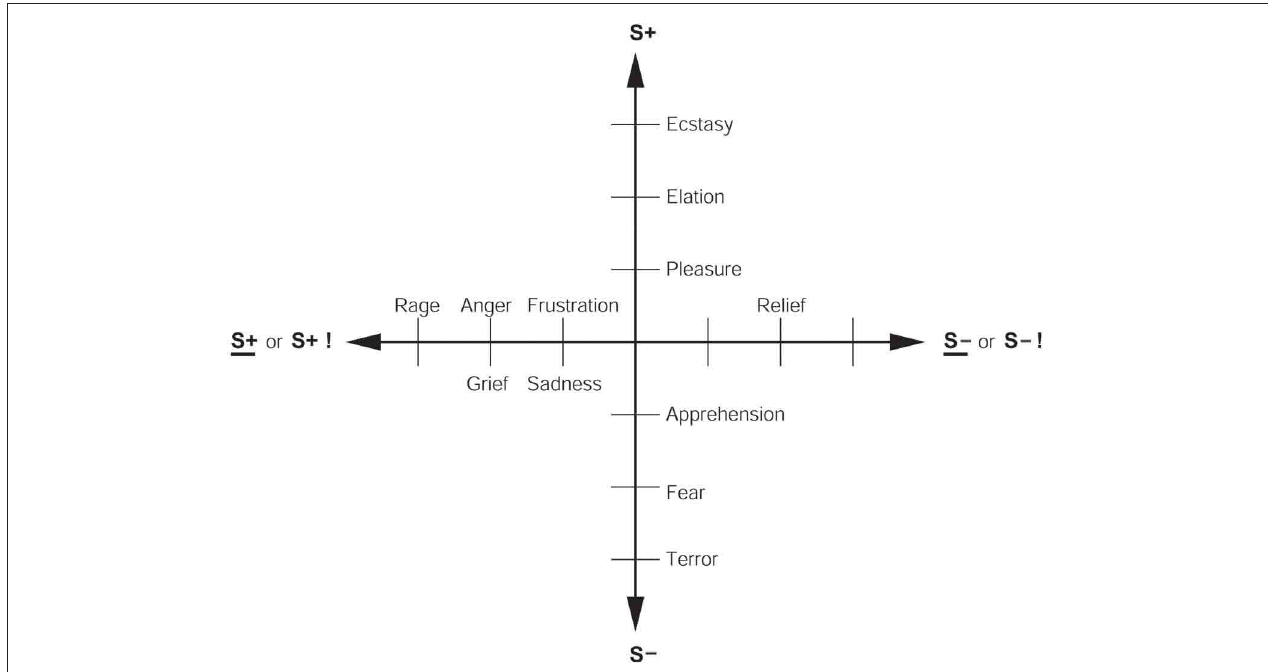
FIGURE 1 | Some of the emotions associated with different reinforcement contingencies are indicated. Intensity increases away from the center of the diagram, on a continuous scale. The classification scheme created by the different reinforcement contingencies consists of (1) the presentation of a positive reinforcer (S + ), (2) the presentation of a negative reinforcer (S − ), (3) the omission of a positive reinforcer (S + ) or